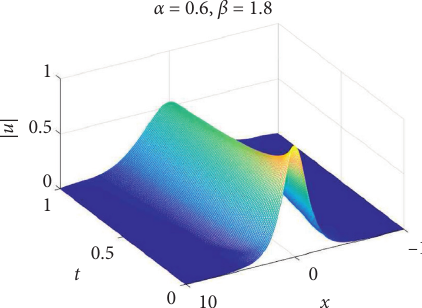
Figure 5: The trace of the solution to | u | of FCNLSE (32) with α � 0 . 6 and β � 1 .